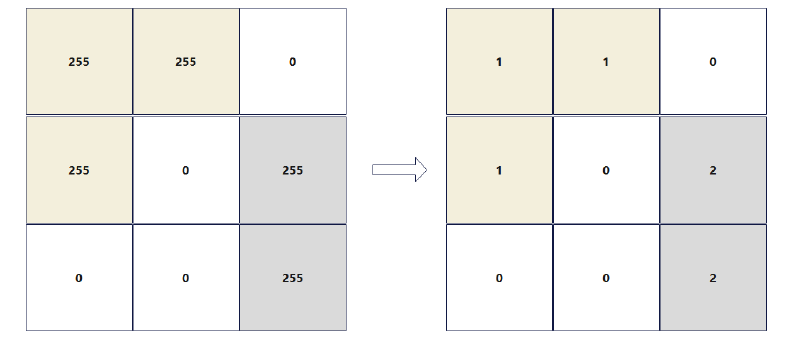
Figure 9. Principle of connected component